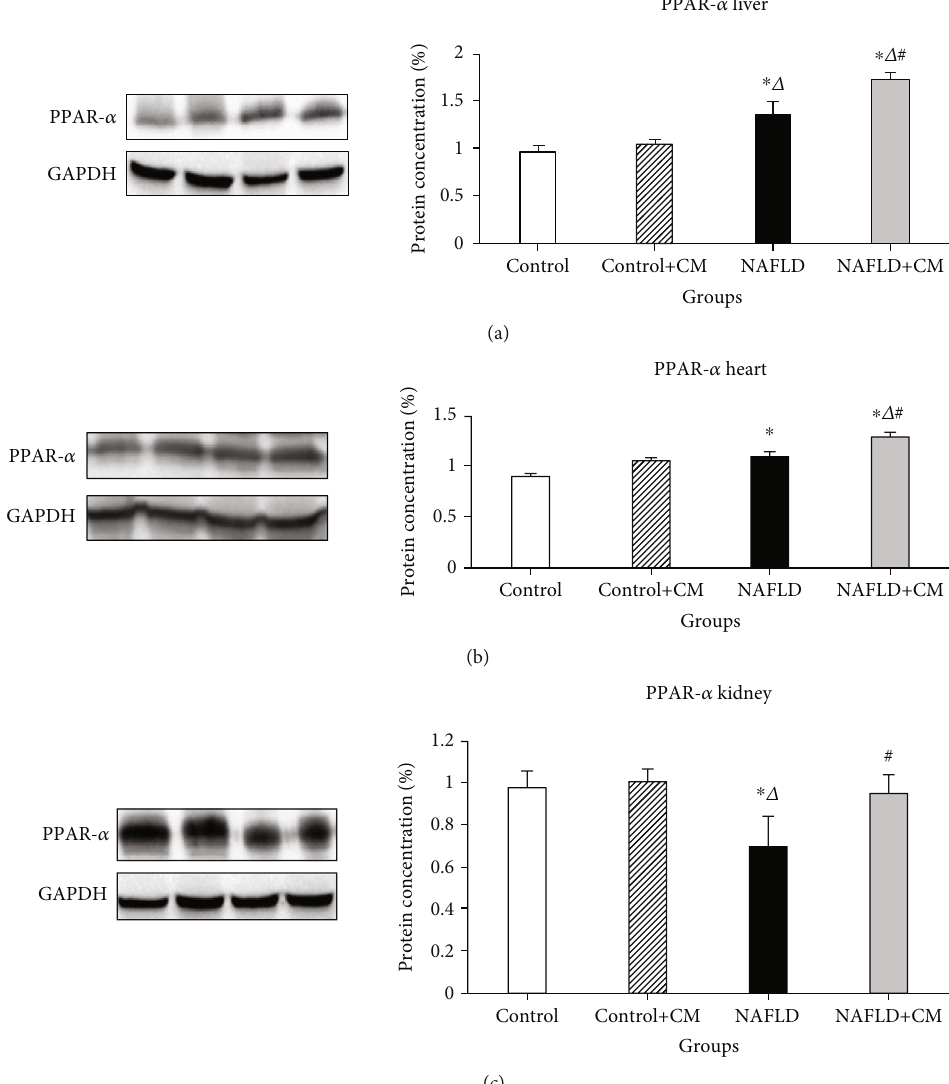
Figure 1: PPAR- α protein expression in the liver (a), heart (b), and kidney (c) tissues of the control, camel milk (CM) treated control (control +CM), nonalcoholic fatty liver disease (NAFLD), and CM-treated NAFLD (NAFLD+CM) animals. The protein bands were quanti fi ed relative to GAPDH. ∗ p < 0 : 05 versus the control group, Δ p < 0 : 05 versus the control+CM group, and # p < 0 : 05 versus the NAFLD